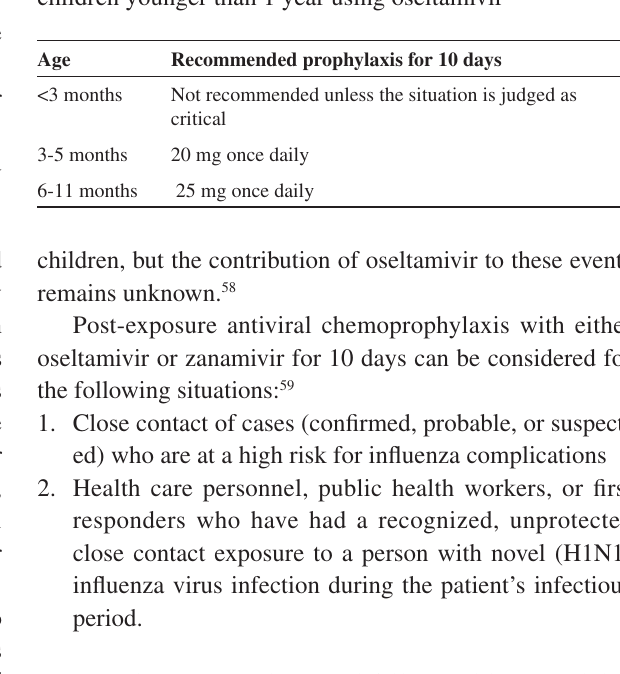
Table 3 - Recommended antiviral chemoprophylaxis